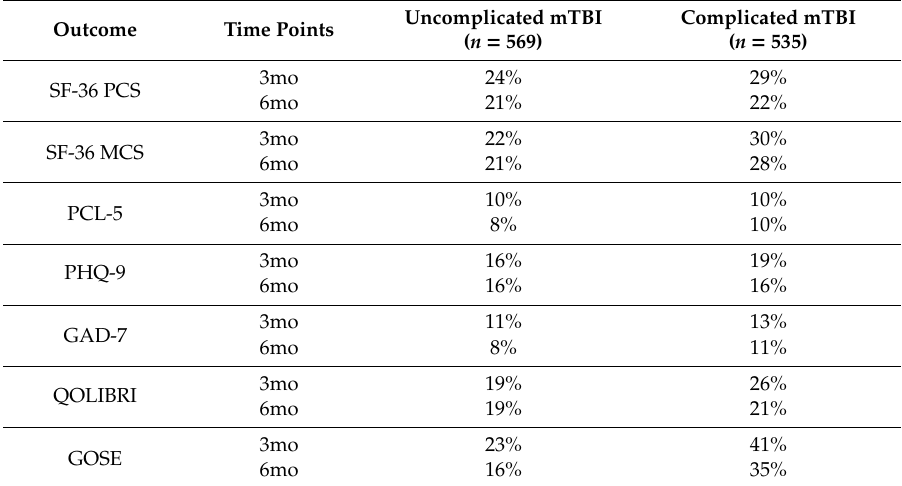
Table 2. Percentages of impaired individuals according to the respective cut-o ff values. Uncomplicated mTBI Outcome Time Points ( n =